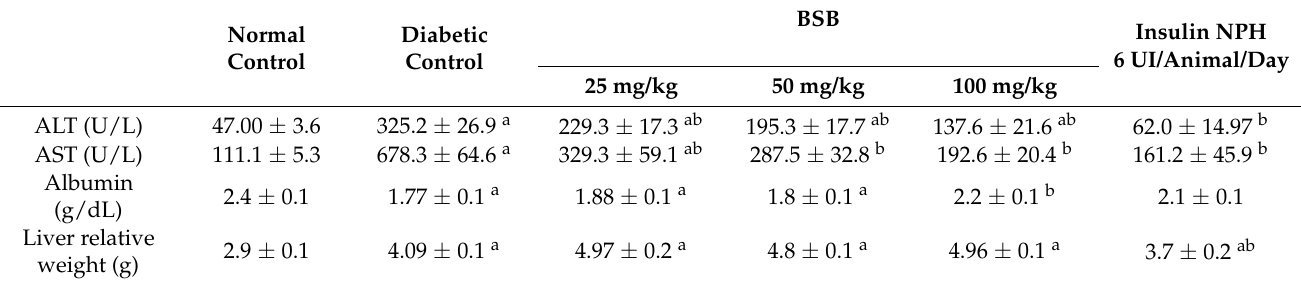
Table 3. Liver function and injury markers in STZ-induced diabetic rats treated with bacuri seed butter ( Platonia insignis Mart.).